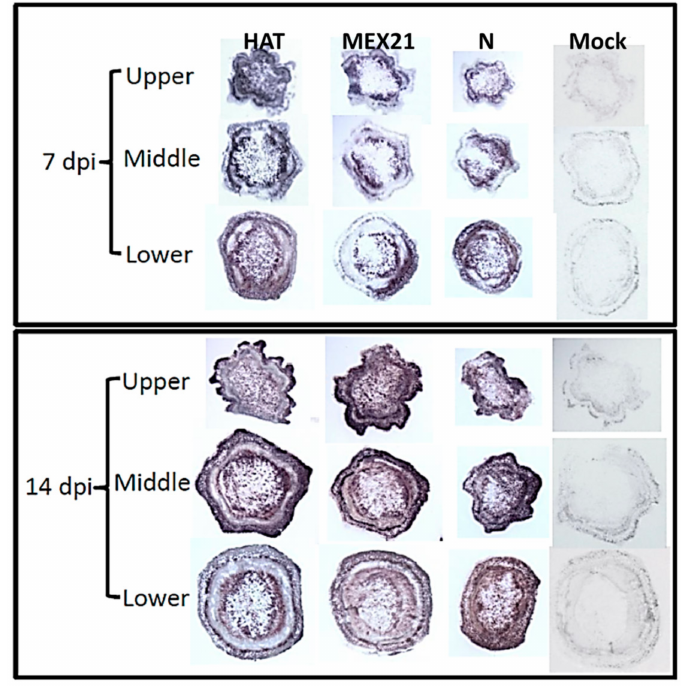
Figure 2. Accumulation of Tobacco etch virus (TEV) strains HAT, Mex21 or N in stem segments of Calwonder pepper plants. Virus accumulation was determined by immuno-tissue blot analysis at 7 and 14 days post-inoculation (dpi). Stem segments include the internode below inoculated leaves (lower), immediately above inoculated leaves (middle) and an upper internode close to the apical bud. The antibody-antigen (viral coat protein) reaction is detected by development of a reddish/brown stain. Buffer-mock control plants (Mock) were examined in a similar manner as viral treated samples and show no stain indicating no viral